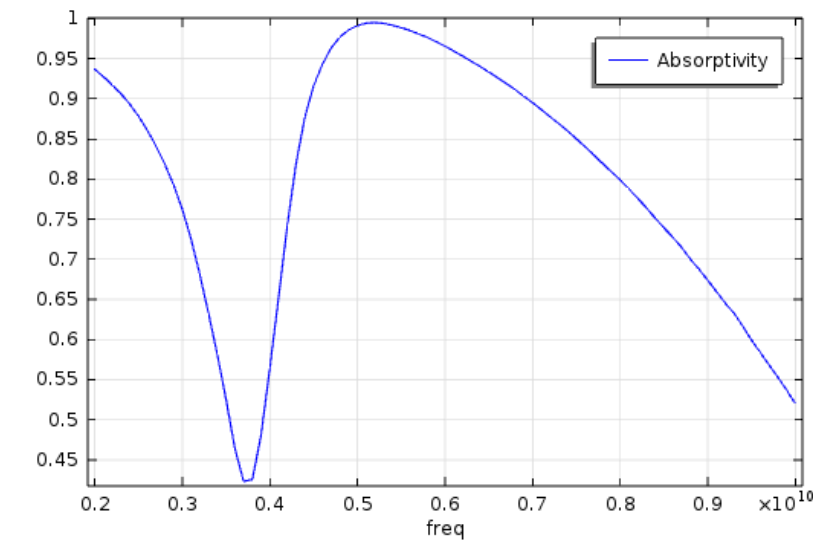
Figure 4. Absorptivity vs frequency, for SRR2.